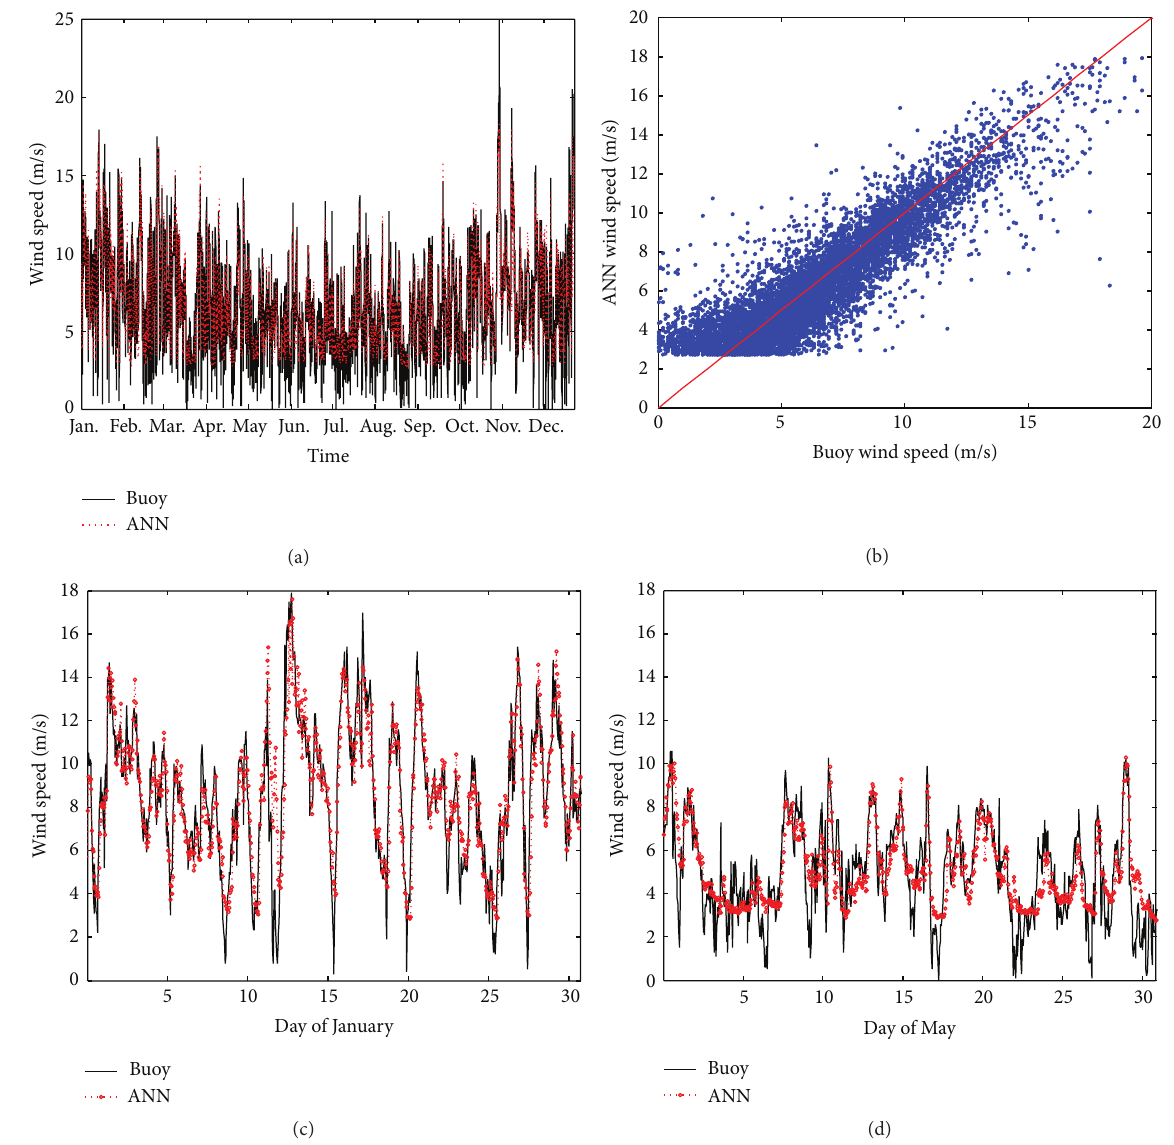
Figure 3: Buoy wind speed estimation in 2012 by the ANN trained with the buoy data of 2011. (a) Time sequence of the whole year. (b) Scatter plot. (c) Time sequence in January. (d) Time sequence in May.